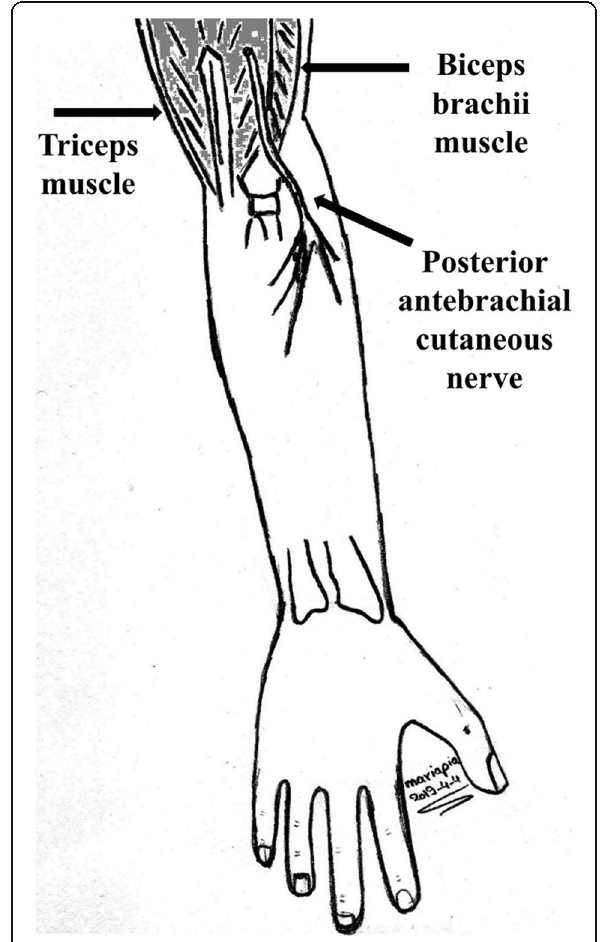
Fig. 4 Terminal anatomical course of posterior antebrachial cutaneous nerve [3, 15, 17]